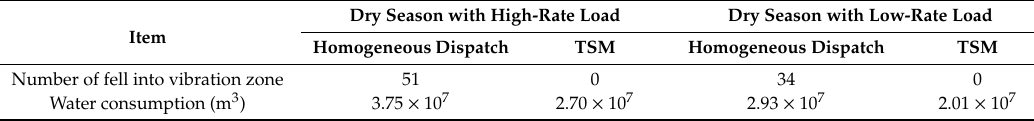
Table 4. Comparison of homogeneous dispatch and two-stage model